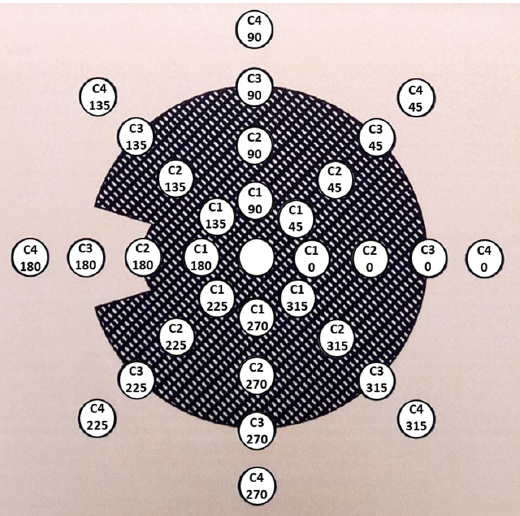
Figure 2. Figure of the distribution of the surface measurement points taken from the calibration certificate of a COC plaque. The relative dose rate value inside each circle has been replaced by the position label adopted in this work, where C1, C2, C3, and C4 refer to the four different concentric circles, and the number below indicates the angular position in each circle.